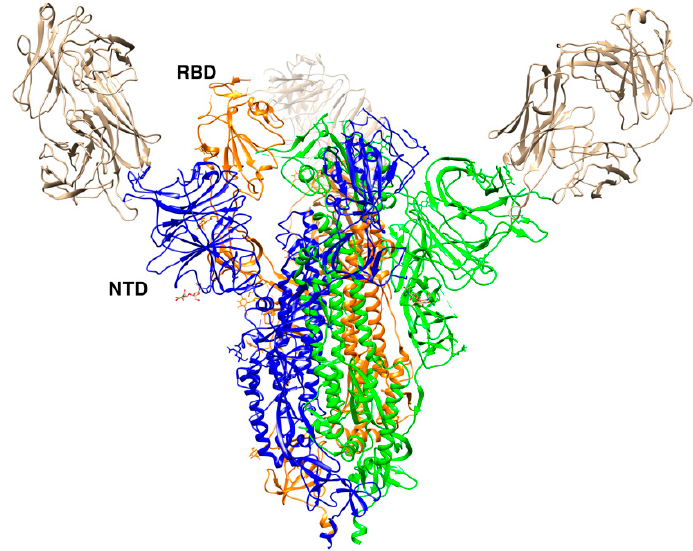
Figure 10. Crystal structure of SARS-CoV-2 RBD with 4A8 (PDB id 7c2l). The RBD in the “up” conformation is labelled. The trimer is colored in blue (B), green (C), and orange (A). The three 4A8 antibodies, each bound to an NTD, are shown in brown.